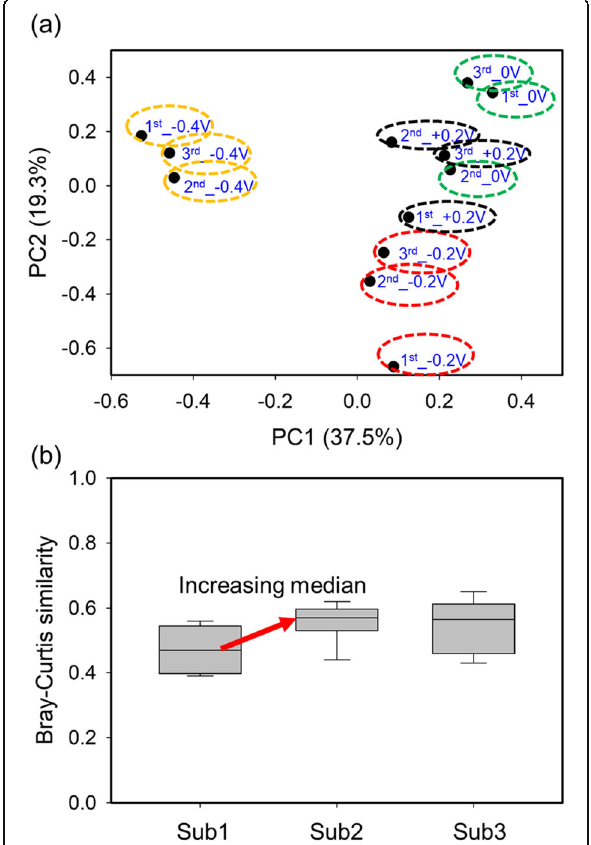
Fig. 4 Genus level differences among microbial compositions. ( a ) Cluster analysis by PCoA. ( b ) Differences within different substages by Bray – Curtis similarity shown in box plot. Anode samples at substage 1 was referred to Sub1; anode samples cultivated at substage 2 was referred to Sub2; anode samples cultivated at substage 3 was referred to